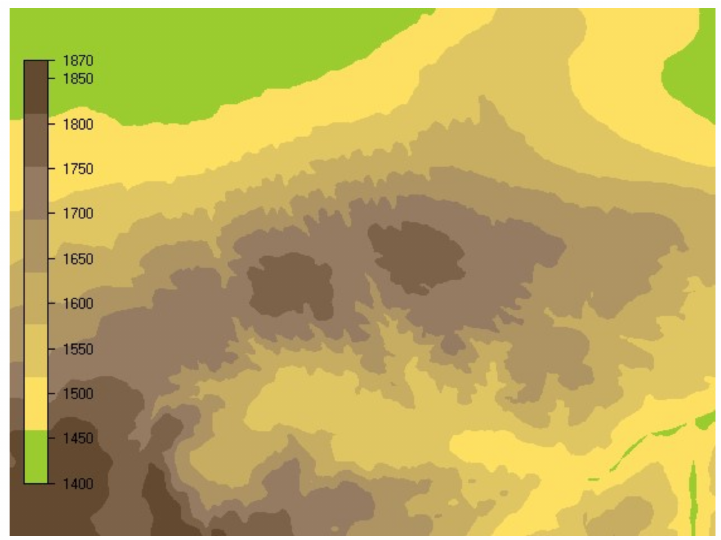
Figure 4. Elevation distribution within wind farm